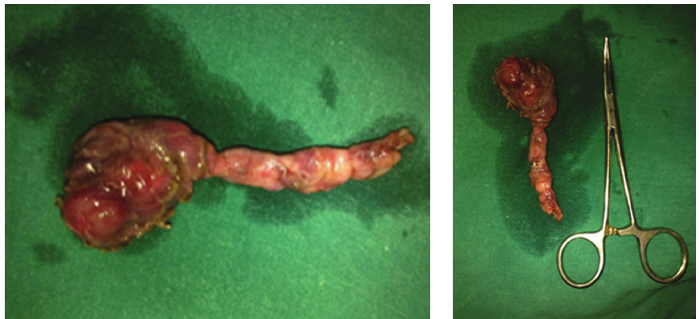
Figure 2: Surgical specimen showing cyst with fibrous cord tracking inferiorly up to the superior